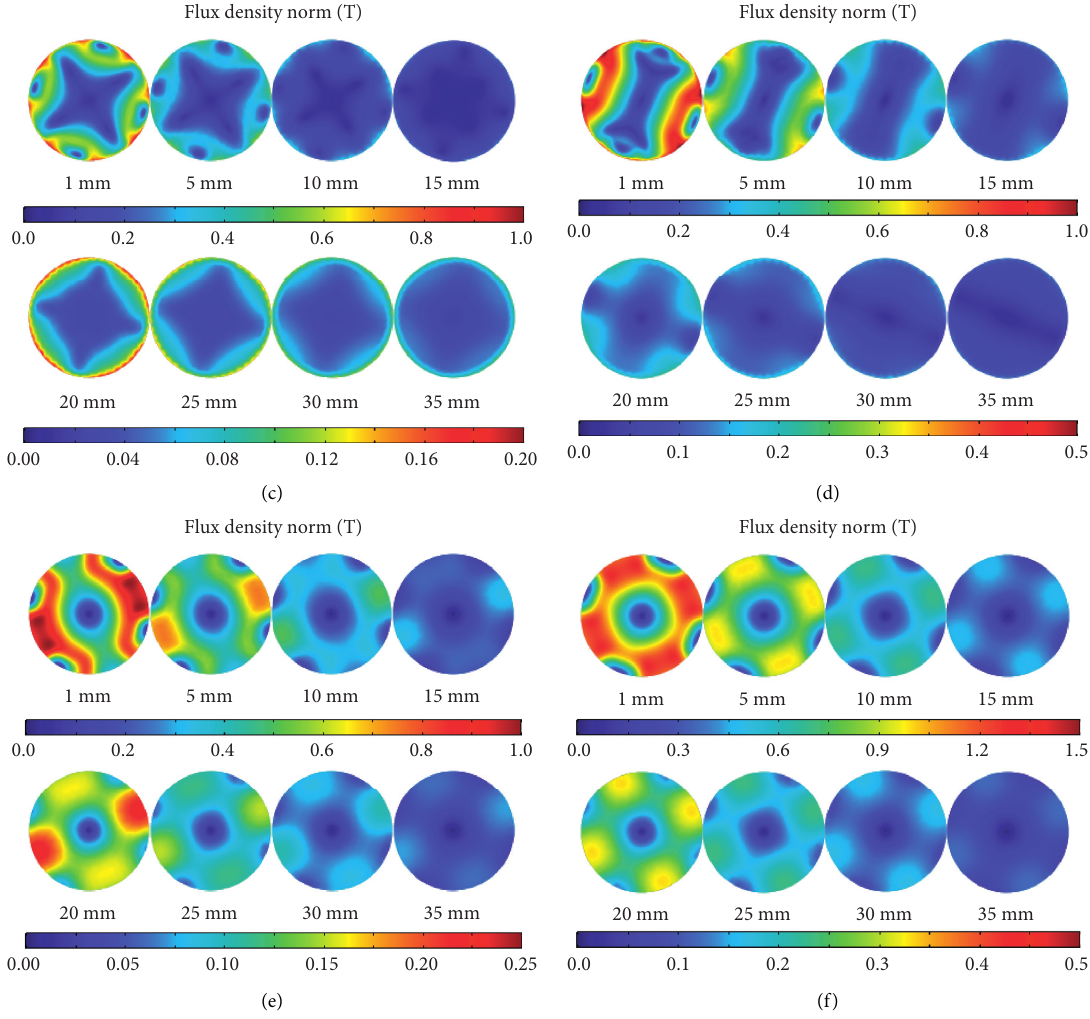
Figure 14: Magnetic flux density norm nephogram of the valve cover when the valve seat consists of eight identical shape tile magnets. (a) Scheme 10. (b) Scheme 11. (c) Scheme 12. (d) Scheme 13. (e) Scheme 14. (f) Scheme 15.